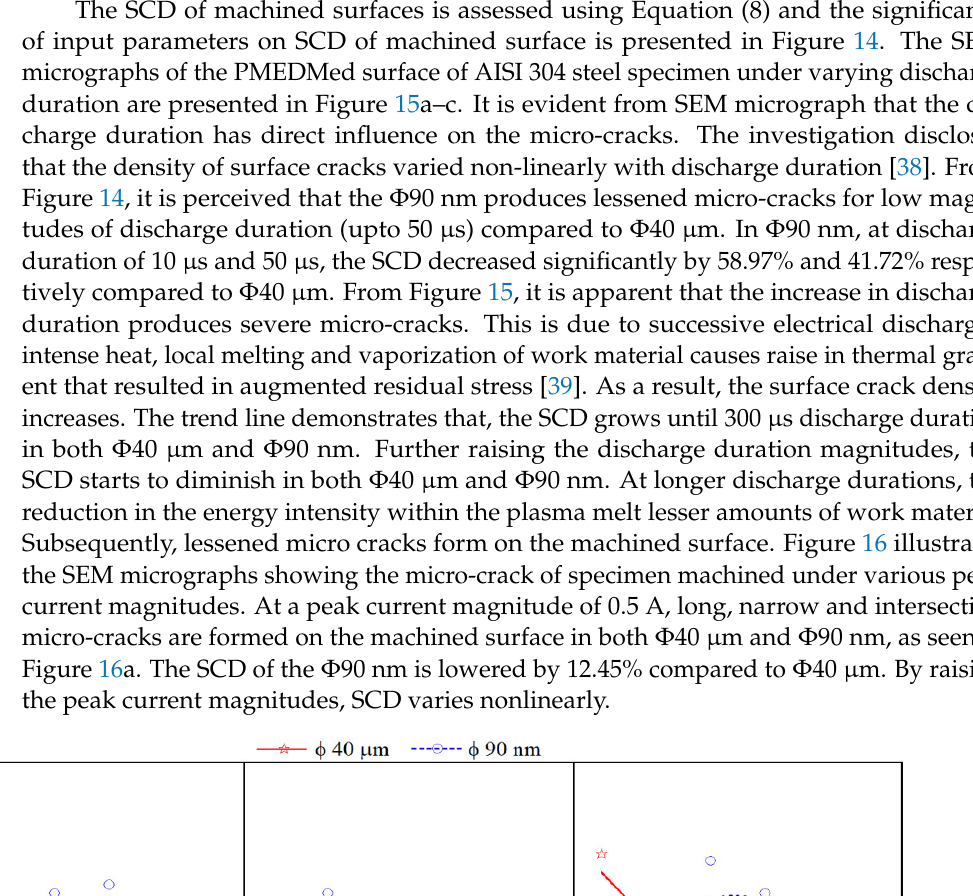
Figure 15. SEM micrographs with various discharge durations.